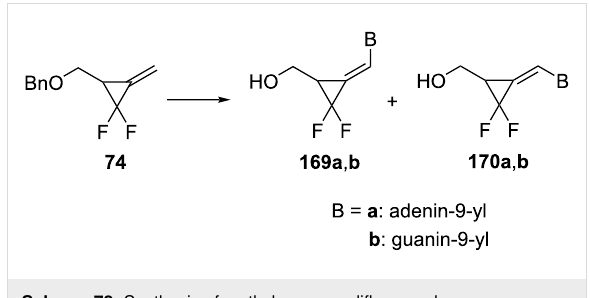
gem -difluorocyclopropyl carbocyclic nucleosides for use against